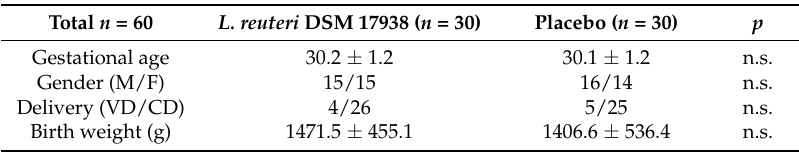
Table 1. Clinical and demographic data at